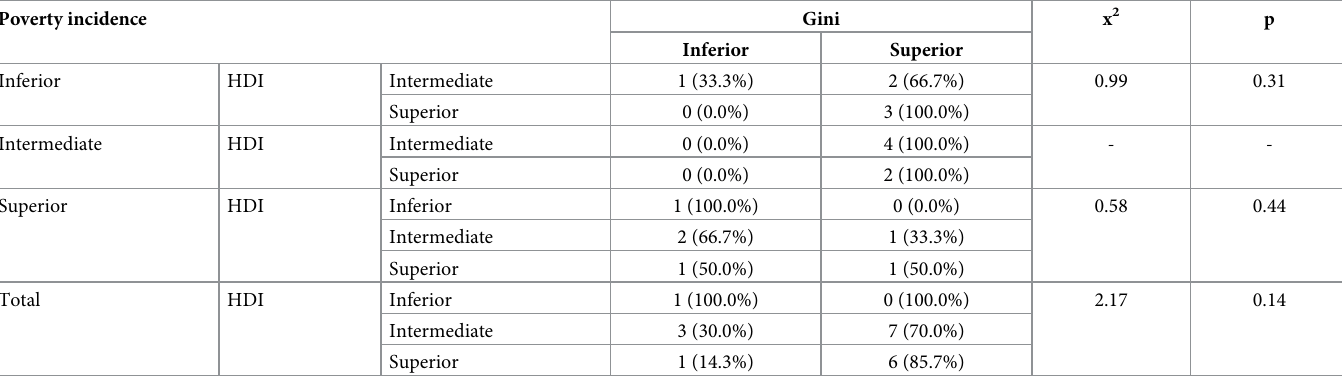
Table 1. Relationship between human development index, Gini coefficient, and poverty incidence in inland cities of Northeast Brazil, 2020. Poverty incidence Gini x 2